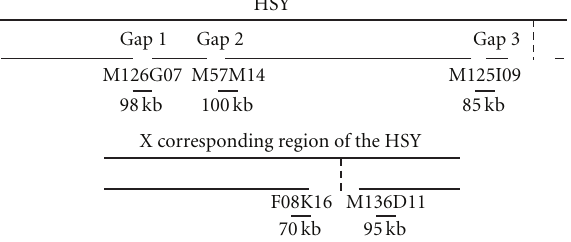
Figure 3: Illustration of gap filling using the male and female BAC libraries. The estimated size of the HSY is 8-9 Mb and the size of the corresponding X region is approximately 5-6Mb. One gap remains in both the HSY and corresponding X physical maps. BAC clones from the male and female BAC libraries were labeled starting with “M” or “F”, respectively. The insert size of each BAC is labeled below the bar representing the